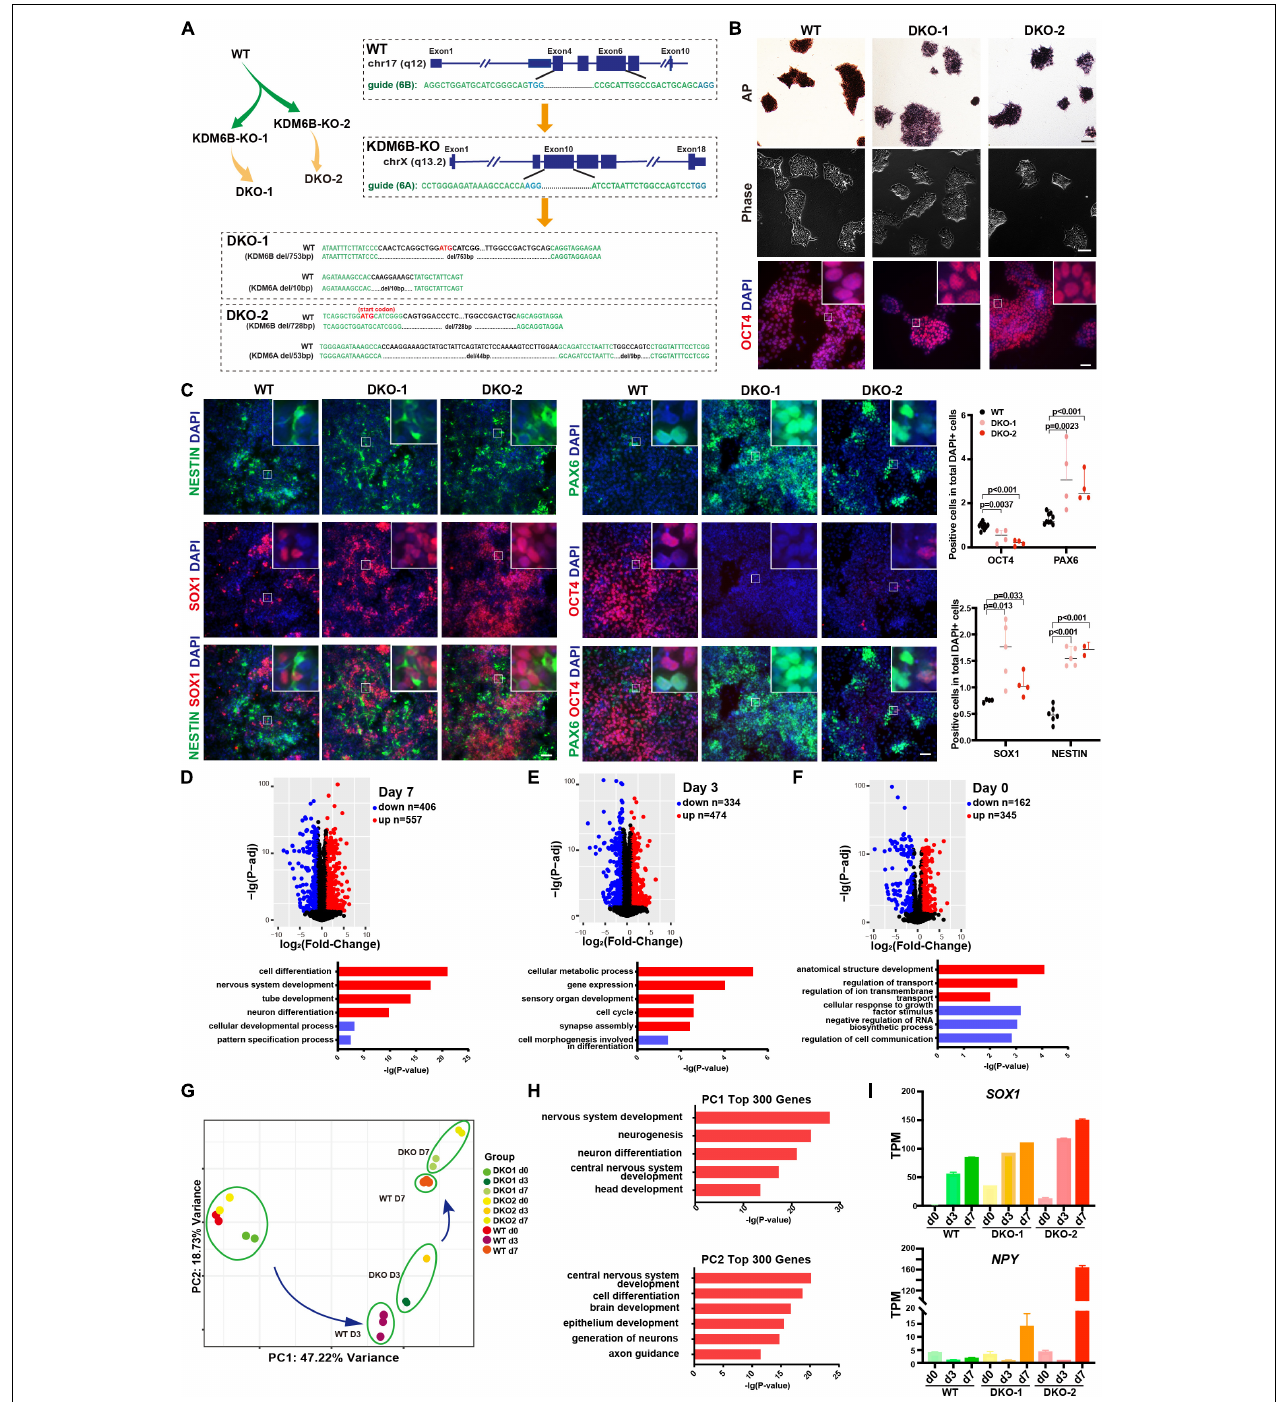
FIGURE 4 | The double knockout of KDM6A and KDM6B promoted the neuroectoderm differentiation. (A) Illustration of the strategy to make KDM6 double-knockout cells. The genotypes of two double knockouts at KDM6A and KDM6B loci are shown. (B) The AP staining, morphology, and immunofluorescence staining of the pluripotent marker OCT4 in the KDM6-DKO and wild-type cells at undifferentiated ESC states. The scale bar for AP and morphology is 100 µ m, while the scale bar for OCT4 staining is 50 µ m. (C) The immunofluorescence staining images (left) and quantification (right) of pluripotent and neural markers in the KDM6-DKO cells after 7 days of neuroectoderm differentiation. Scale bar = 50 µ m. (D–F) GO analysis of the differentially expressed genes between KDM6-DKO and wild-type cells at differentiation day 7 (D) , day 3 (E) , and day 0 (F) . (G) PCA analysis of the KDM6-DKO and wild-type cells at different stages based on RNA-seq data. (H) GO analysis of top 300 genes for PC1 and PC2 in (G) based on RNA-seq data. (I) The expression level of SOX1 (representing PC1) and NPY (representing PC2) at different stages in KDM6-DKO and wild-type cells.